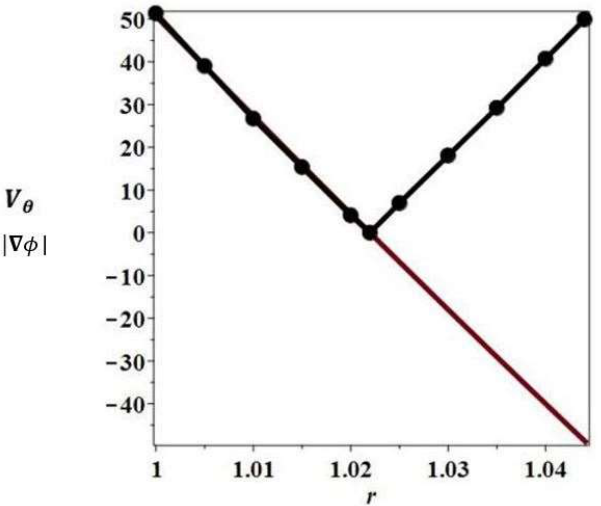
(cid:3095) , Ra = 100 and R = 2 1/16 obtained analytically (continuous (cid:2870)